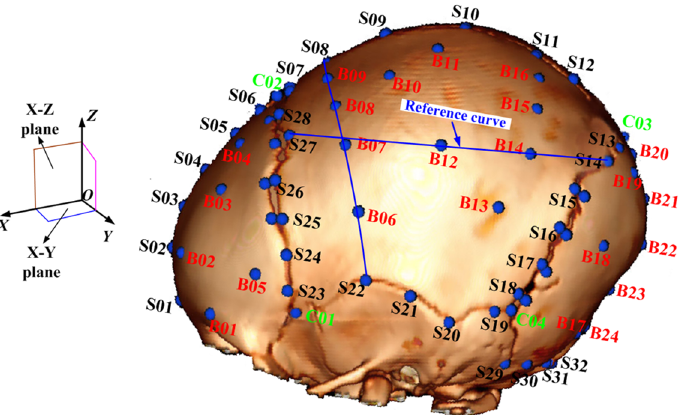
Fig 2. Landmarks on the skull surfaces and suture-bone boundaries. Note: B01 to B24 represent landmarks located at the skull (bone) surface, S01 to S32 represent landmarks located at the suture center lines, and C01 to C04 represent landmarks located at the intersections of the sutures. Landmarks on the skull surface are generally evenly distributed on the reference curves. For example, landmark No. B12 on the skull surface is midway between landmarks No. S27 and S14; and landmark No. B14 is in the middle of landmarks No. B12 and